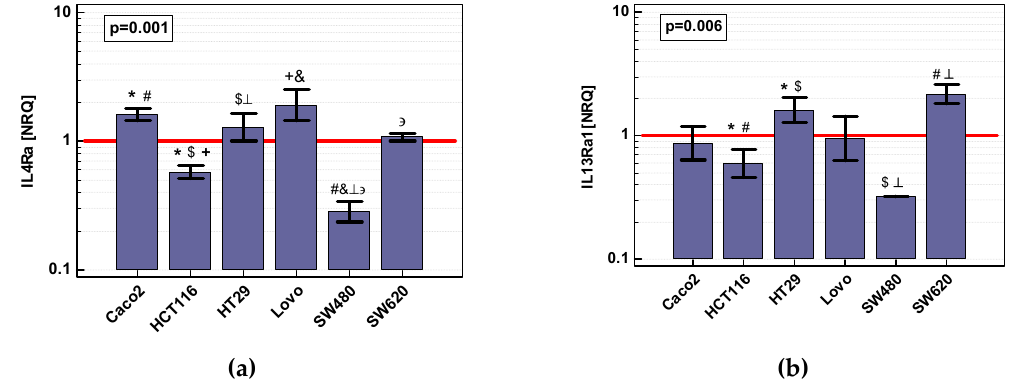
Figure 10. Relative expression of IL4Ra and IL13Ra1 in colon cancer cells lines: ( a ) IL4Ra ; ( b ) IL13Ra1 . Data analyzed as logs using one-way ANOVA and presented as geometric means ± SE ( n = 2–6) of normalized relative quantities [NRQ]. Expression levels were normalized against GAPDH expression and presented in relation to geometric mean of gene expression across all samples (represented by horizontal red line). Statistically significant differences between groups are marked with symbols of the same type (*, #, etc.).